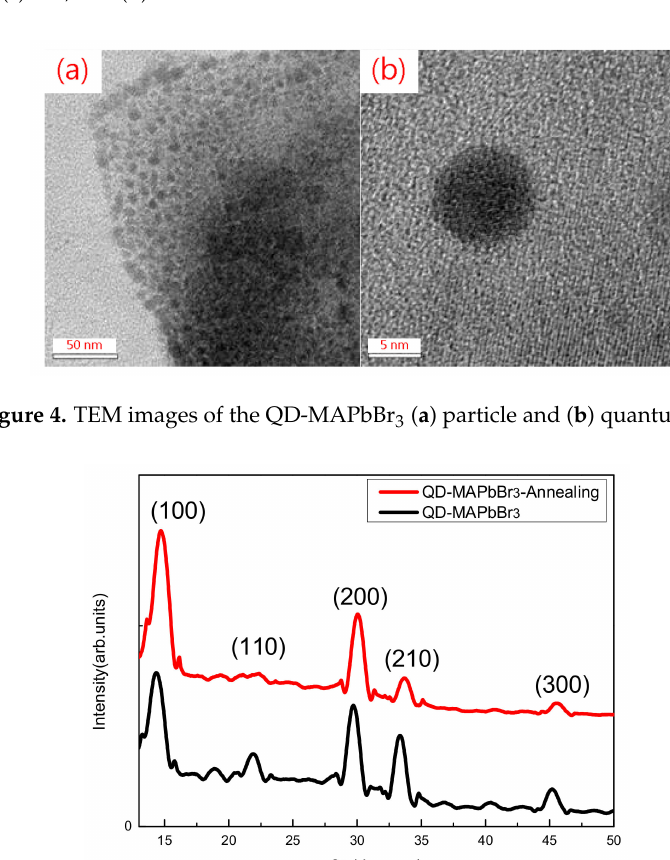
Figure 3. SEM images of the surface morphologies of the QD-MAPbBr 3 films for the reaction times of ( a ) 30; ( b ) 120; ( c ) 240; and ( d ) 360 min.